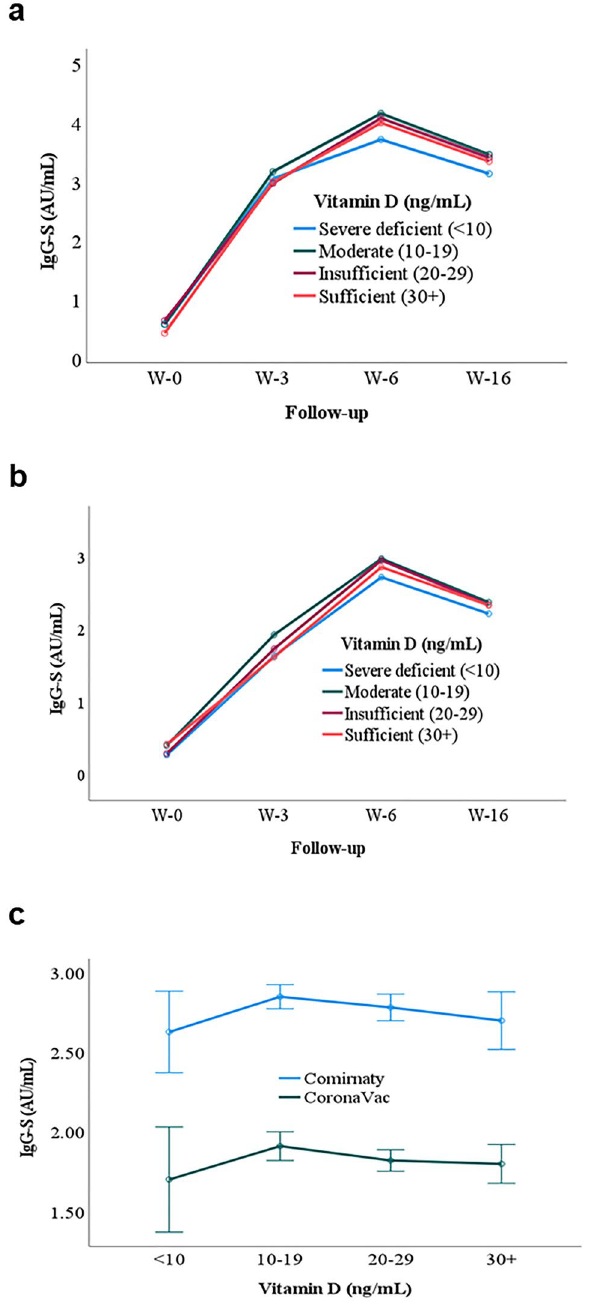
Figure 5. VitD and antibody kinetics. ( a ) Comirnaty, ( b ) CoronaVac. Graphs show the geometric mean IgG-S values of different VitD levels against the follow-up. ( c ) Comparison between the geometric mean of IgG-S resulting from Comirnaty and CoronaVac against the VitD level. W-0, Week zero; W-3, Week three; W-6, Week six, W-16, Week